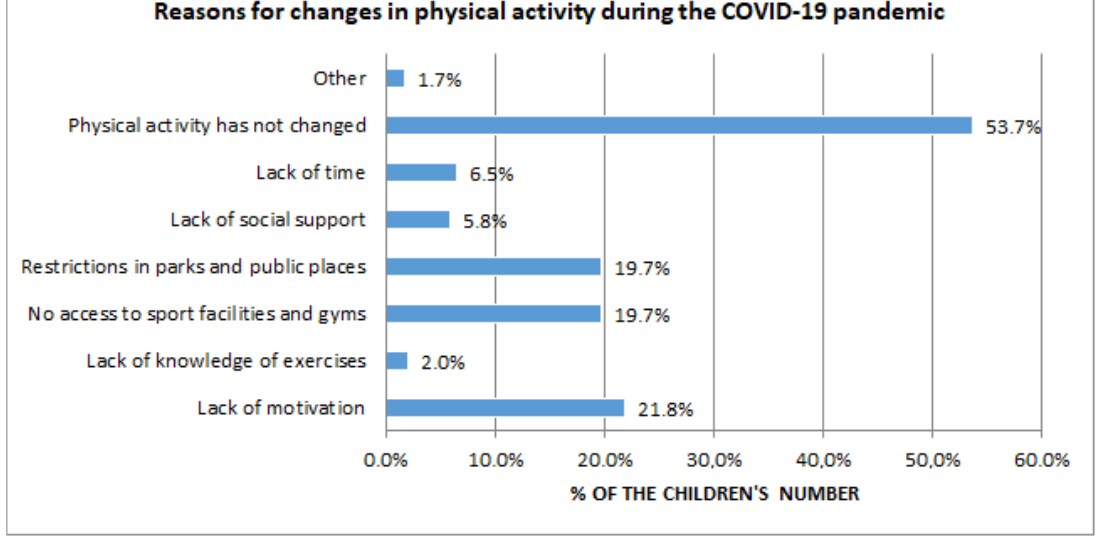
Figure 4. Reasons for changes in physical activity during the COVID-19 pandemic.